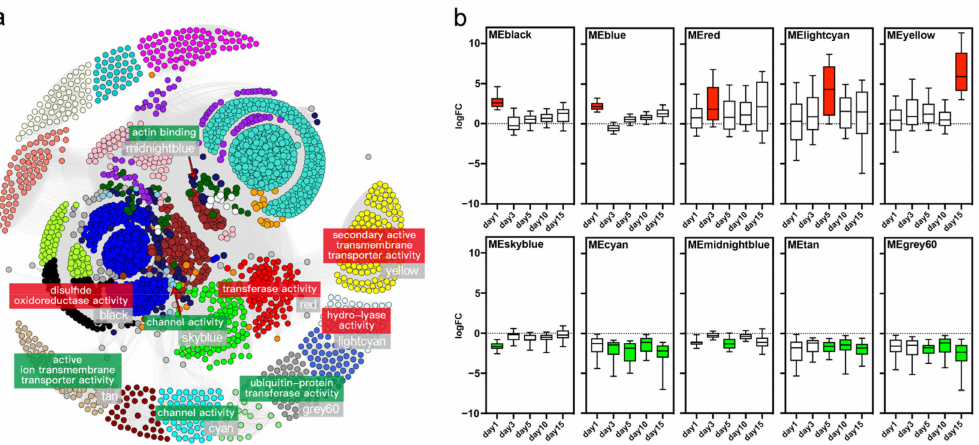
Figure 2. ( a ) Gene co-expression network in gills after exposure to A. minutum . For network visu- alization, each module is represented by a different color. Representative significant GO terms are shown for each responsive module. ( b ) The boxplot of DEGs for ten responsive modules based on the fold change of their expression